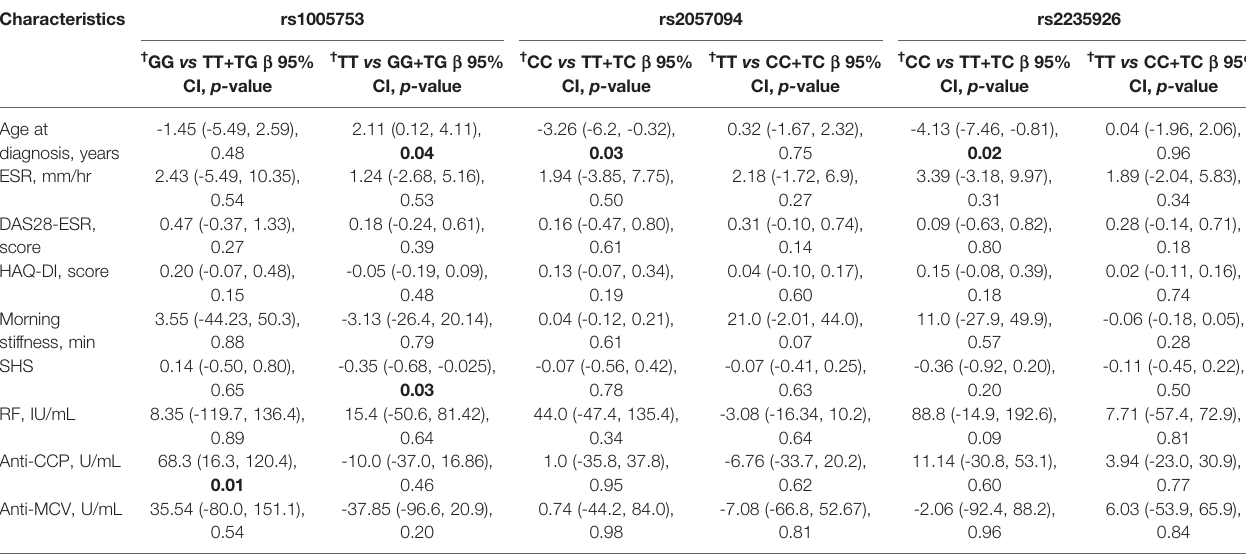
TABLE 5 | Effect of PADI2 SNPs on the clinical characteristics in RA patients.